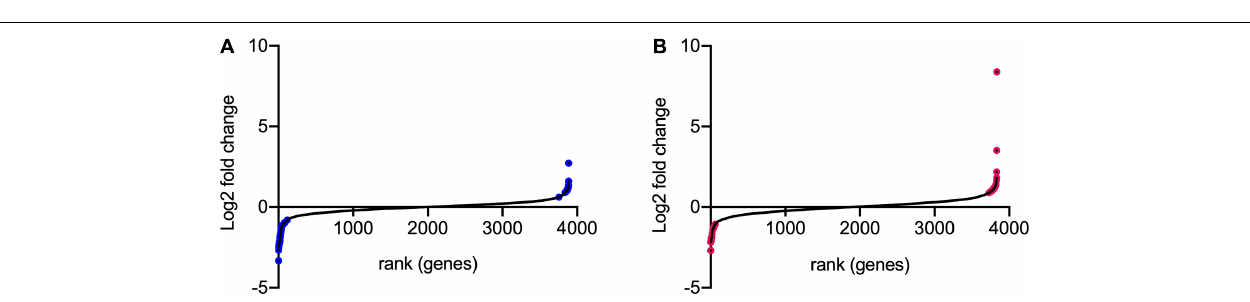
FIGURE 4 | Log 2 FC of transposon insertion frequency for all non-essential genes. The log 2 FC for each non-essential gene was calculated for (A) 30 min stress/control and (B) 90 min stress/control. Log 2 FC values were then ranked from lowest to highest. Genes colored in blue and pink are those with logFC > 1 or < –1 and with adjusted p -values <